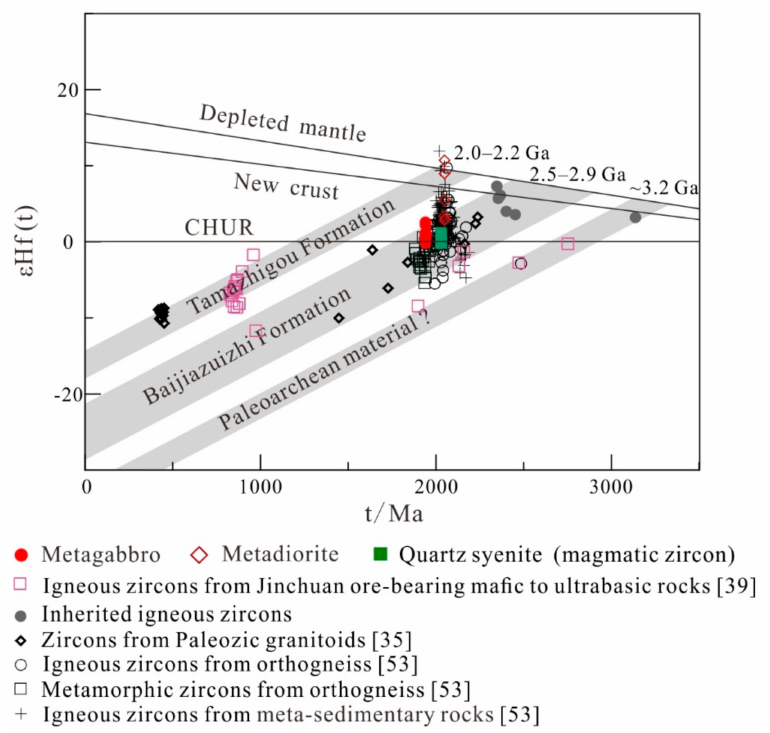
Figure 10. Zircon ε Hf(t)-age(Ma) diagrams. Depleted mantle: 176 Lu/ 177 Hf = 0.0384 [64]; CHUR: 176 Lu/ 177 Hf = 0.0332